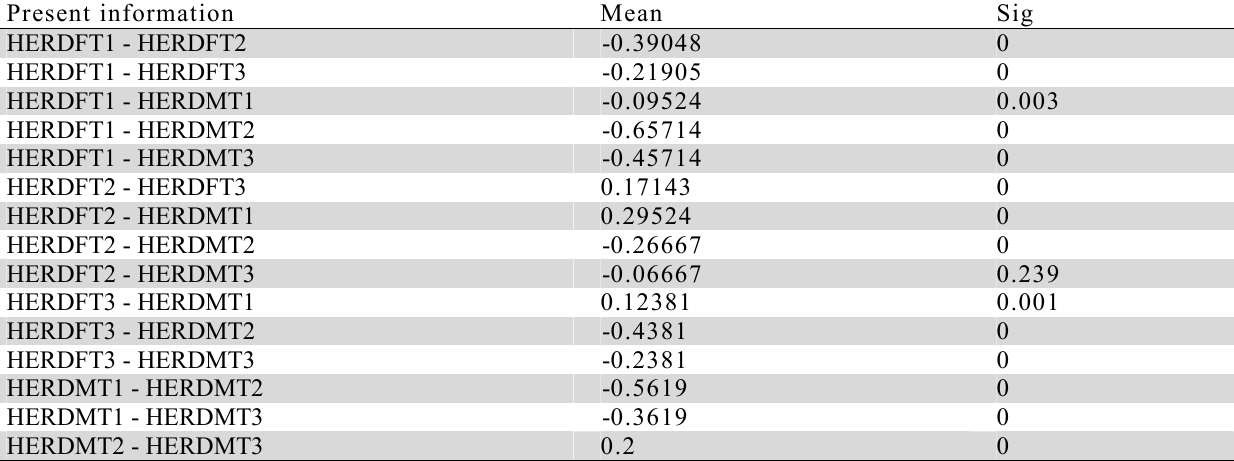
The results of testing the first